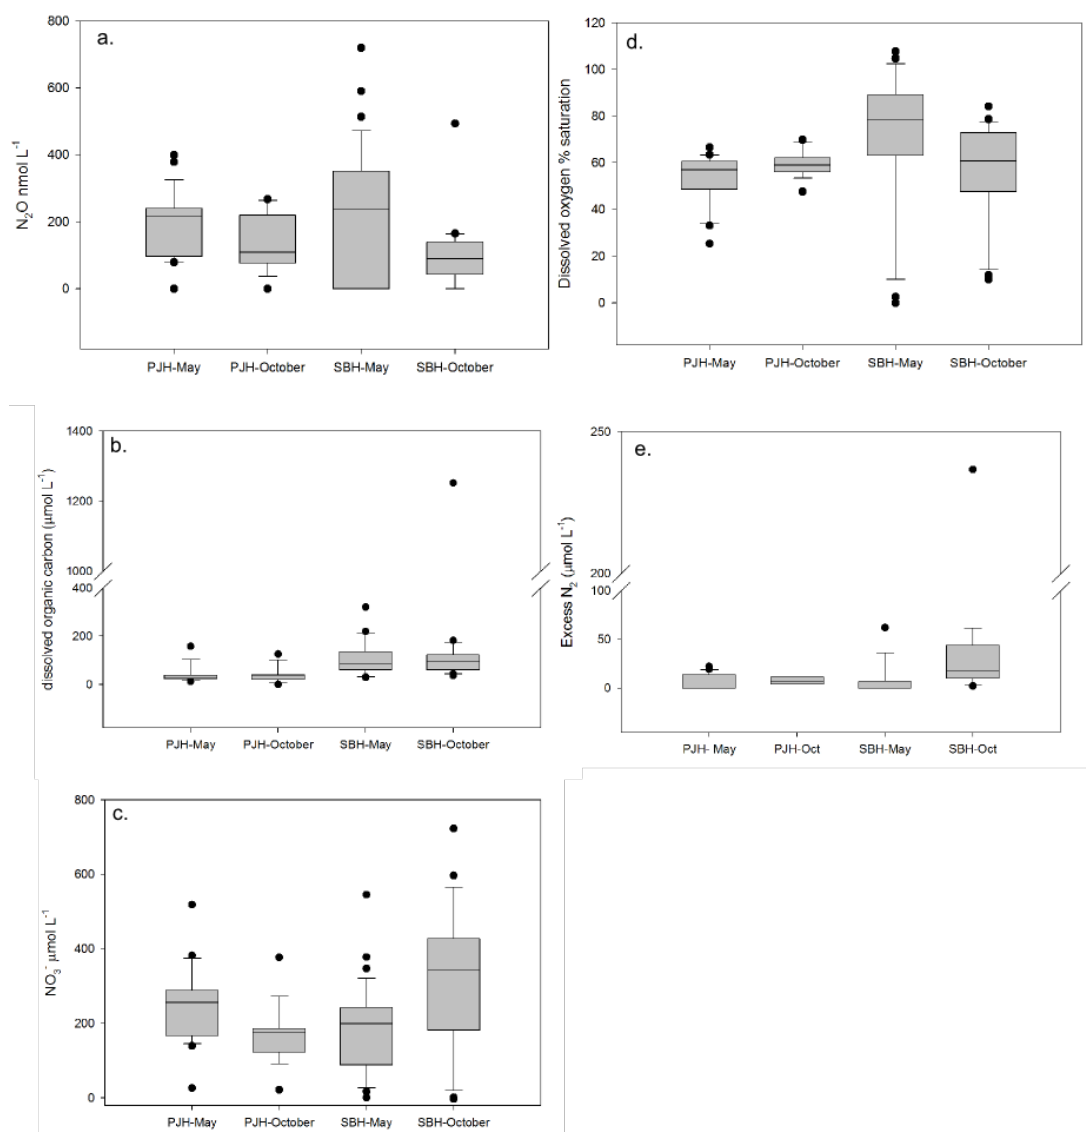
Figure 3. Box-and-whisker plots of ( a ) N 2 O concentrations; ( b ) dissolved organic carbon concentrations; ( c ) NO 3 − concentrations; ( d ) dissolved oxygen % saturation and ( e ) N 2 denitrification concentrations for SBH and PJH porewater in May and October.